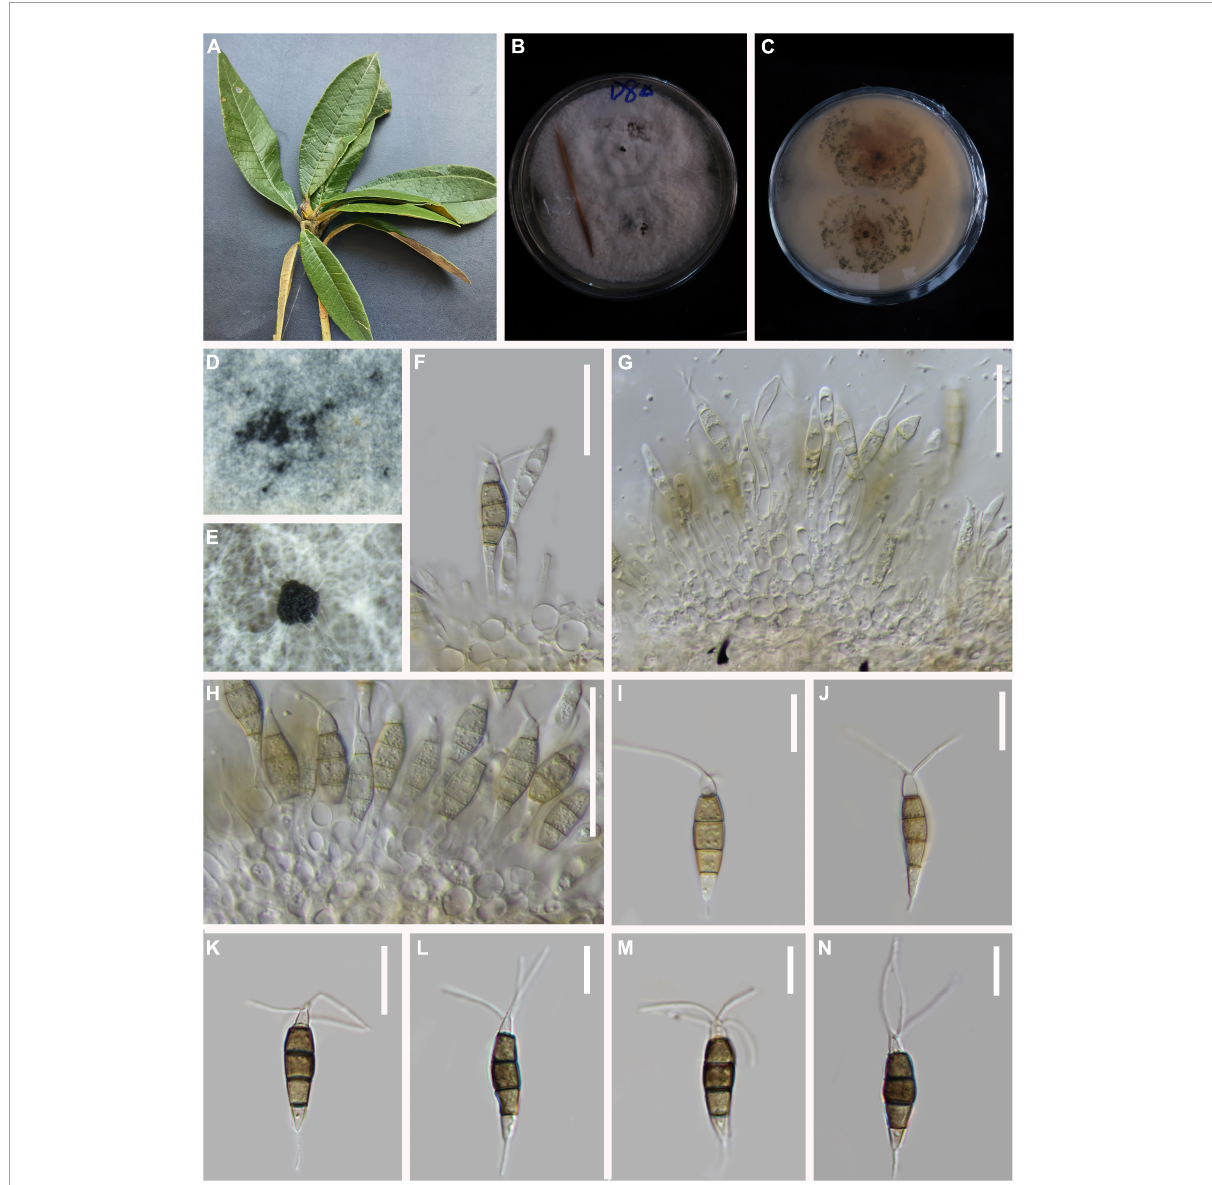
FIGURE5 Pestalotiopsis fusoidea (KUN-HKAS 124579, holotype). (A) Leaves of Rhododendron delavayi . (B,C) Culture on potato dextrose agar (PDA) (upper and lower view). (D,E) Conidiomata on PDA. (F–H) Conidiophores, conidiogenous cells, and conidia. (I–N) Conidia. Scale bars: (F–H) 20 µ m, (I–K) 15 µ m, and (L–N) 10 µ